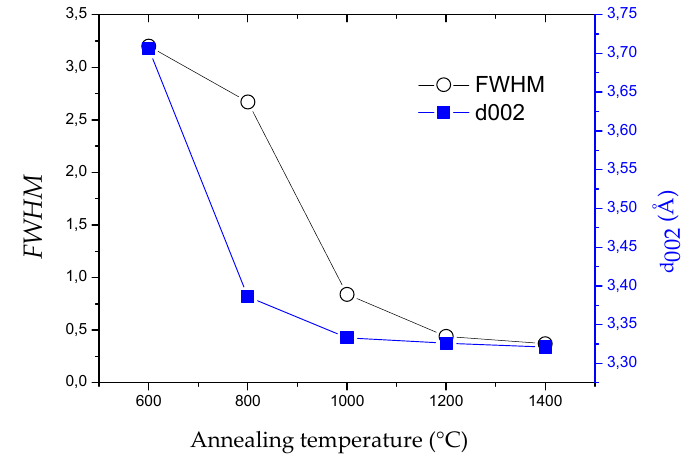
Figure 10. Influence of the annealing temperature on FWHM ( black ) and d 002 ( blue ).